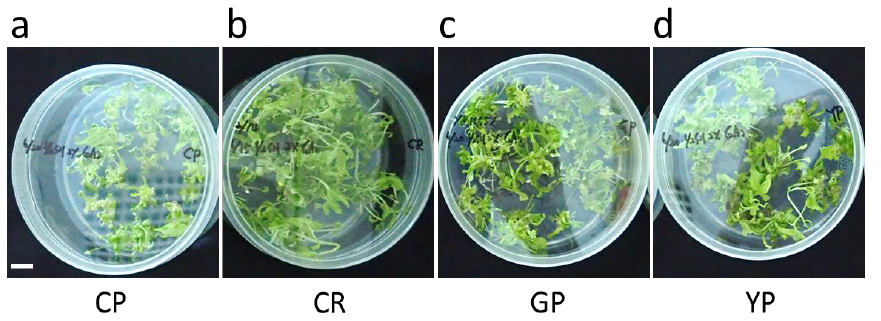
Figure 5. Shoot regeneration in different P. ginseng cultivars. ( a ) Chunpoong, ( b ) Cheonryang, ( c ) Gumpoong, and ( d ) Yunpoong. Scale bars, 1 cm. CP, Chunpoong; CR, Cheonryang; GP, Gumpoong; YP, Yunpoong. Table 5. Influence of cultivars on shoot regeneration of P. ginseng.